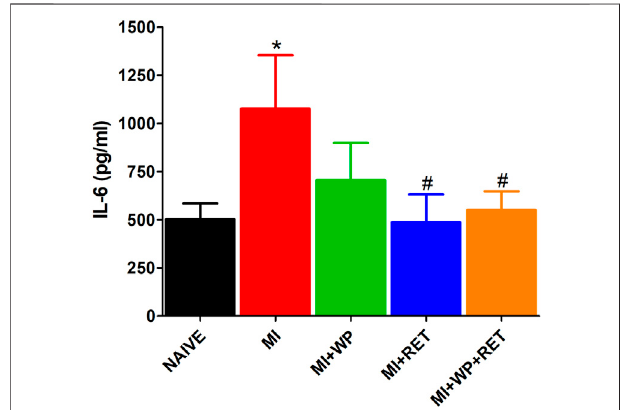
FIGURE 6 | Effect of resistance exercise training (RET) and/or whey protein supplementation (WP) on the pro-in fl ammatory cytokine IL-6 muscle levels. Data are expressed as a mean ± S.E.M of 5 – 6 animals per group. * p < 0.05 indicates a statistical difference compared to the naïve group; * p < 0.05 indicates statistical signi fi cance compared to the muscle injury (MI) group. One-way ANOVA followed by the Bonferroni test.